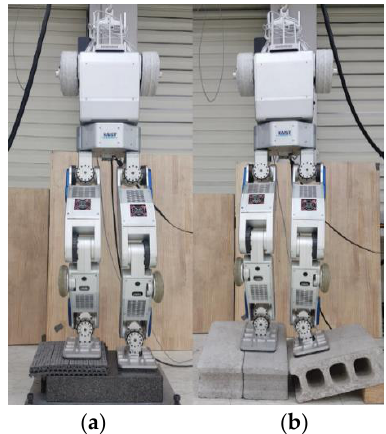
Figure 12. Leg length and foot orientation control on uneven terrain. ( a ) Height difference and ( b ) both height and orientation difference.